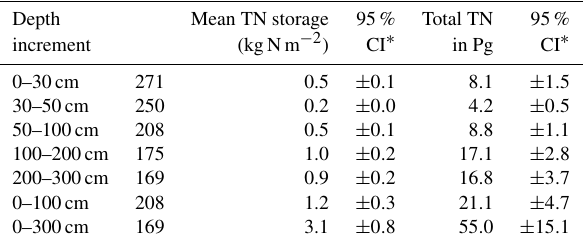
Table 6. Mean and total TN storage with 95% CI for the different depth increments for the northern circumpolar permafrost region, excluding water bodies and permanent snow and